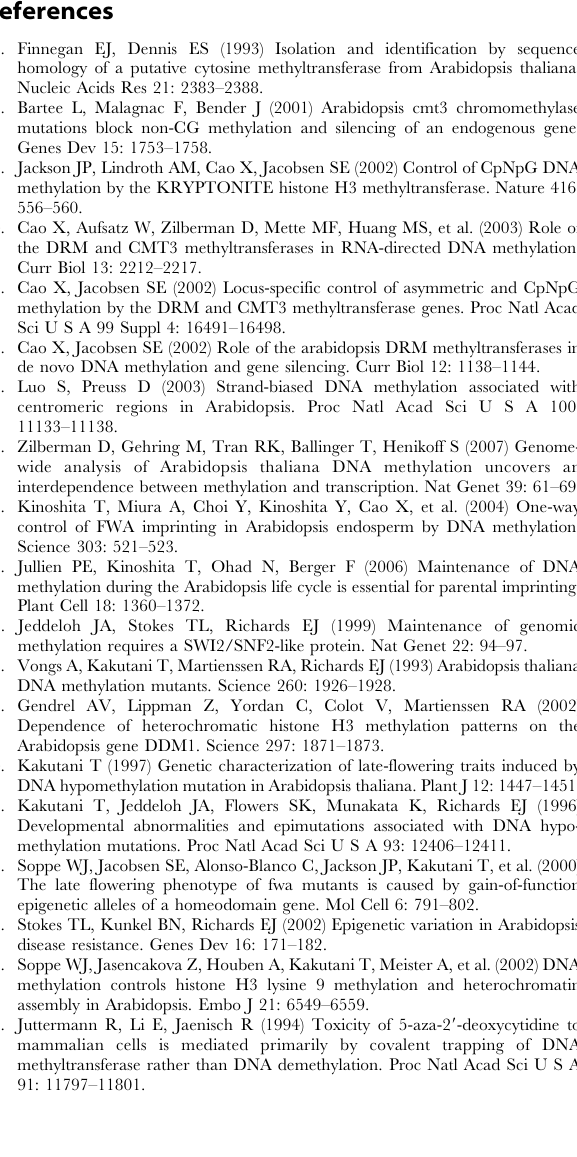
Table S3 Genes significantly downregulated after 5-AC treat- ment. Table S4 Genes with common regulation between 5-AC treatment experiments. Table S5 Overlap between genes upregulated in ddm1 or after 5- AC and other global gene expression studies in chromatin mutants. Table S6 Primer sequences for qPCR.